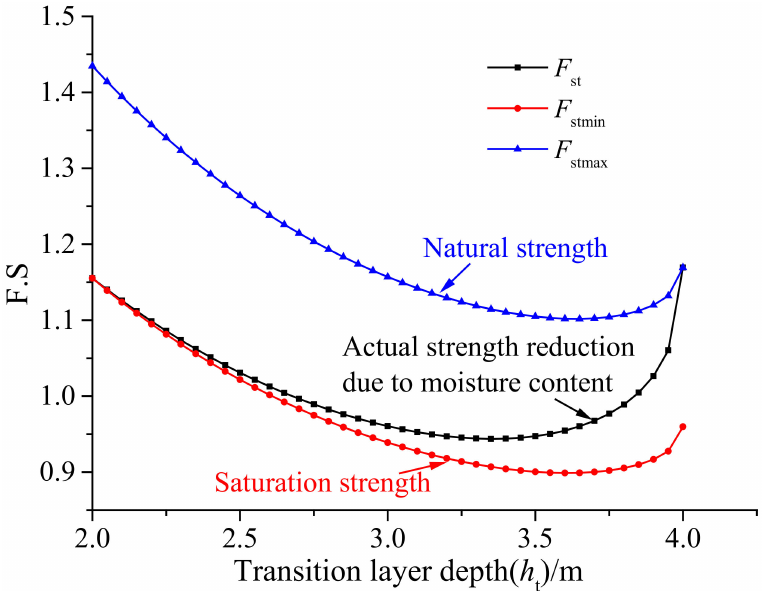
Figure 8. Safety factor in the transition layer versus the transition layer depth ( h s = 2 m and h f = 4 m). Meanwhile, we assumed that the depth of the potential slip surface is proportional to the wetting front depth, i = h min / h f . The depth of the potential slip surface with the wetting front depth ( h f ) and i with λ were calculated, and the results were fitted (see Figures 9 and 10). Figure 10 shows that the fitting degree was high between the calculation data and the fitting function, and R 2 > 0.99. The depth ( h min ) of the potential slip surface increased by linear function with increasing wetting front depth ( h f ) and increased with λ . The ratio ( i ) increased by the exponential function with λ .